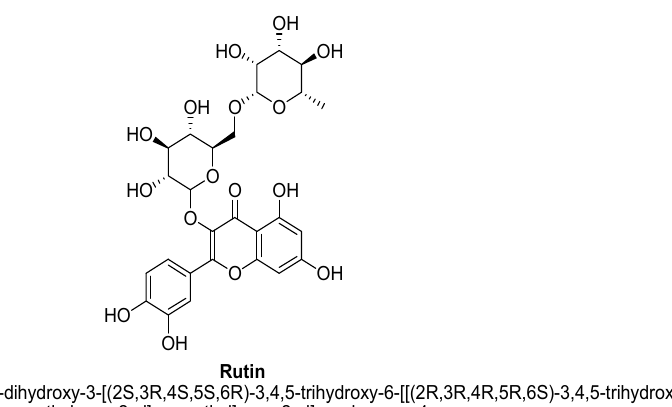
Figure 28. Rutin. SAR of Flavonols